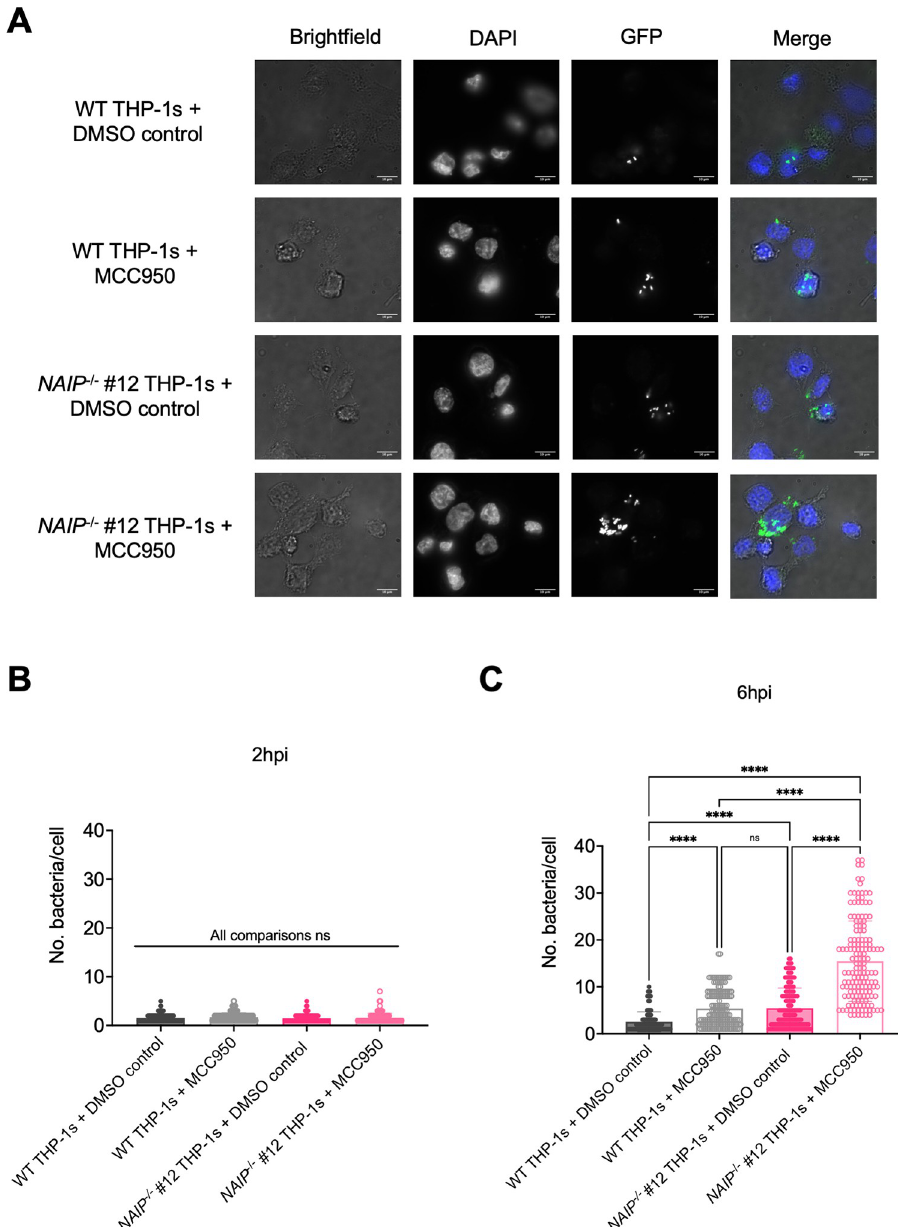
Fig 6. The NAIP/NLRC4 and NLRP3 inflammasomes control Salmonella replication within human macrophages. WT and NAIP -/- THP-1 monocyte-derived macrophages were seeded on glass coverslips and primed with 100 ng/mL Pam3CSK4 for 16 hours. One hour prior to infection, cells were treated with 1 μ M MCC950, a chemical inhibitor of the NLRP3 inflammasome, or DMSO as a control. Cells were then infected with PBS (Mock) or WT S . Typhimurium expressing GFP at an MOI = 20. Cells were fixed at the indicated time points and stained for DAPI to label DNA (blue). The proportion of infected cells containing GFP-expressing Stm (green) and the number of bacteria per cell were scored by fluorescence microscopy. (A) Representative images from 6hpi are shown. Scale bar represents 10 μ m. (B, C) Each small dot represents one infected cell. 150 infected cells were scored for each condition (50 infected cells per coverslip). Bars represent the mean from each condition. (B) Number of bacteria/cell at 2 hpi. (C) Number of bacteria/cell at 6 hpi. ns–not significant, ���� p < 0.0001 by Tukey’s multiple comparisons test (B). Data shown are representative of at least three independent